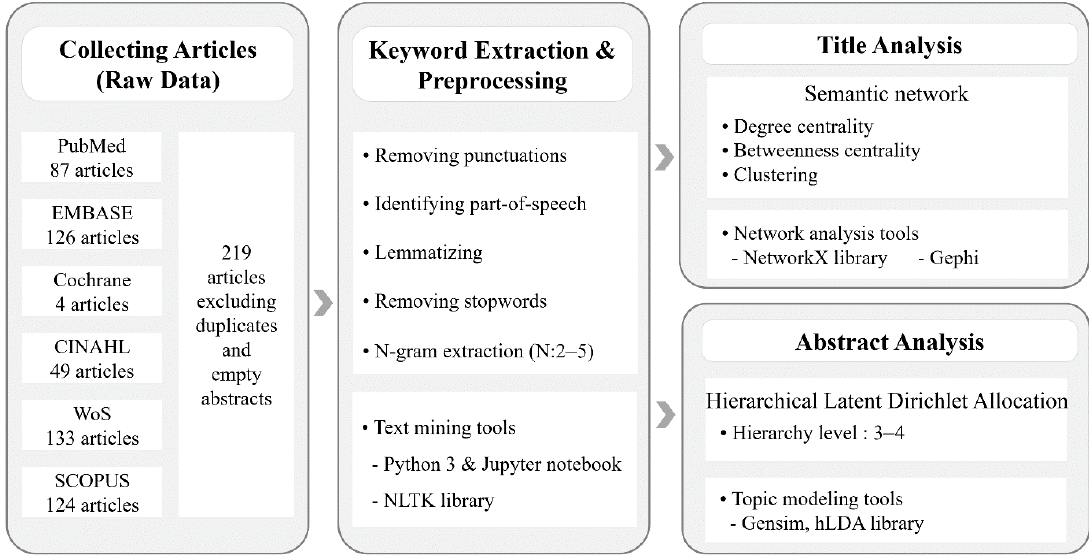
Figure 1. Flow diagram for the text analysis process.